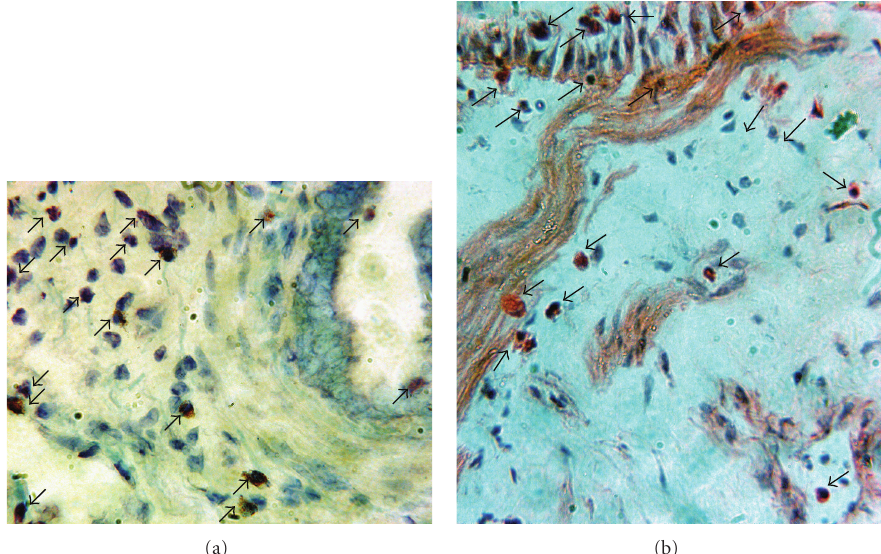
Figure 3: Following overnight incubation adherent eosinophils migrated within the airway wall, including the smooth muscle layer. Eosinophils were found within the epithelium, subepithelium, smooth muscle layer, and loose connective tissue. These panels represent examples of eosinophils identified by Wright’s staining (a) and H&E staining (b) within the airway wall; arrows denote eosinophils